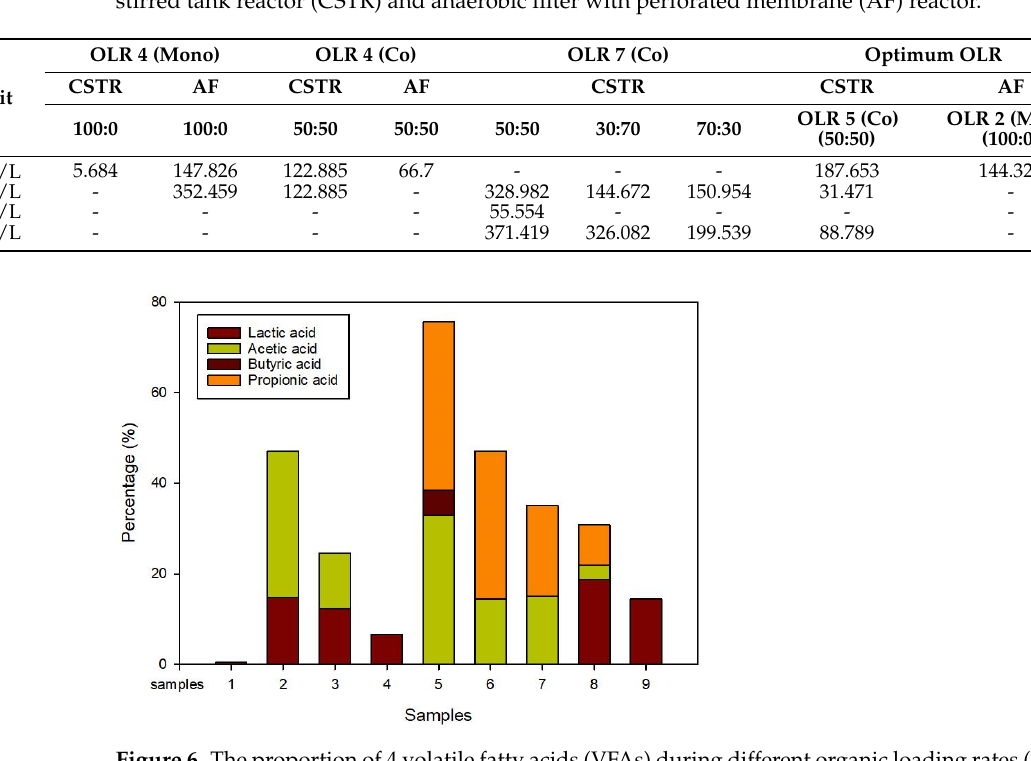
Table 8. Volatile Fatty Acids (VFA) during different organic loading rates (OLRs) for continuous stirred tank reactor (CSTR) and anaerobic filter with perforated membrane (AF) reactor.